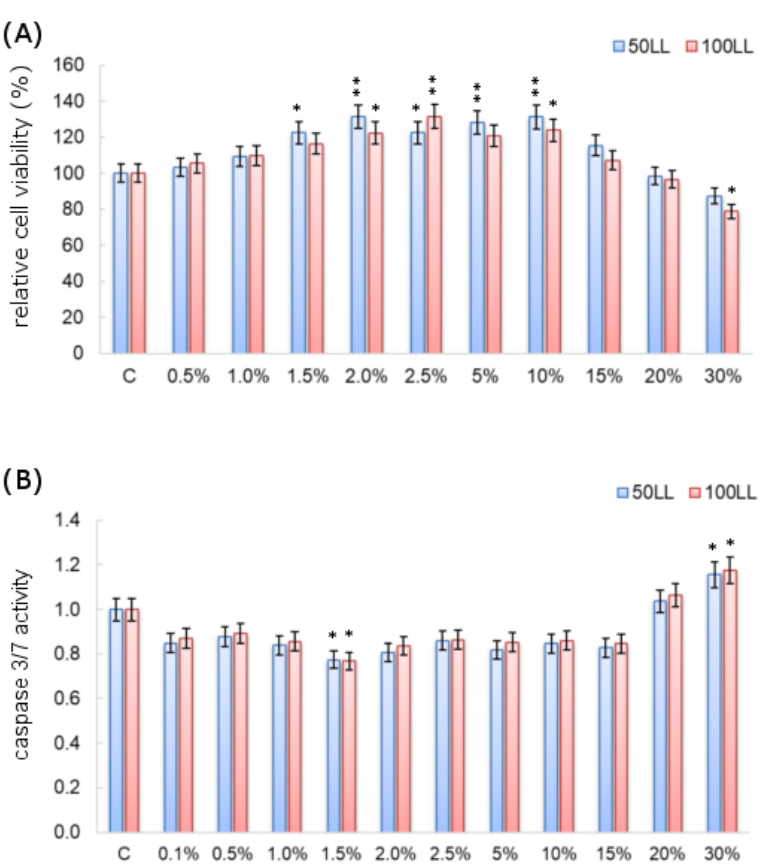
Figure 6. Cytotoxicity ( A ) and apoptosis level ( B ) in Caco-2 cell line after application of soil filtrates (SF) in different concentrations for 24h incubation; each value presented as column with bars represent the mean ( n = 3) with the standard deviation ( ± SD); *— p < 0.05 and **— p < 0.01 describe significant effects between treatments and control assessed by Dunnett’s post-hoc test.